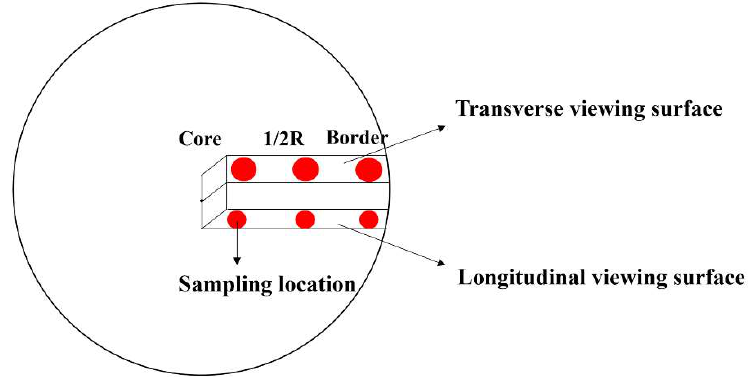
Figure 2. Schematic diagram of sample position.